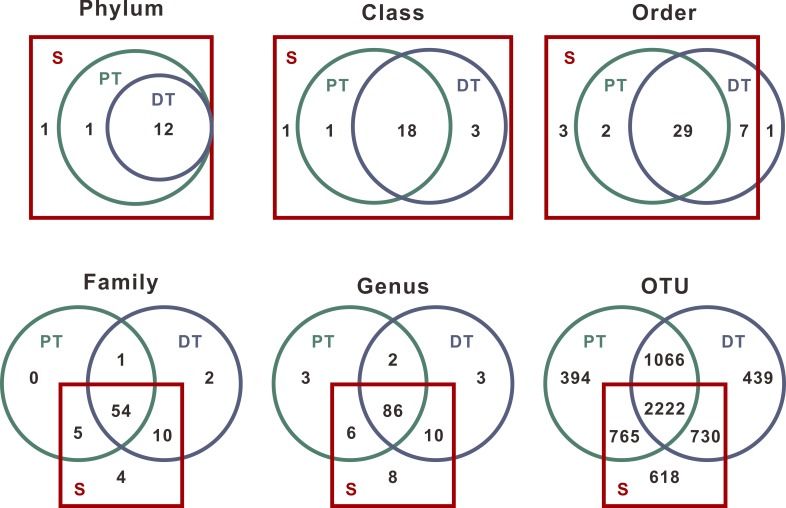
Shared and unique taxa among the three oral cavity niches.Green and blue circles represent the microbial sets of permanent and deciduous teeth plaque samples, respectively. The red rectangle represents the microbial community in saliva. These diagrams depict the relevant relationships of three groups and numbers of taxa contained at different levels. At the phylum and class levels, saliva contained all microbial taxa lodged in the supragingival plaque of permanent and deciduous teeth. At the lower levels, however, the three groups shared most of the detected taxa but also harbored their own.